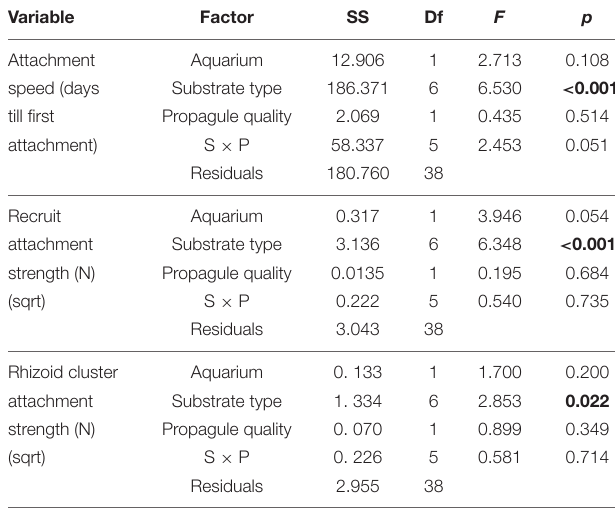
Only fragments that had attached were included in the analysis. Significant p-values are indicated in bold (p < 0.05).